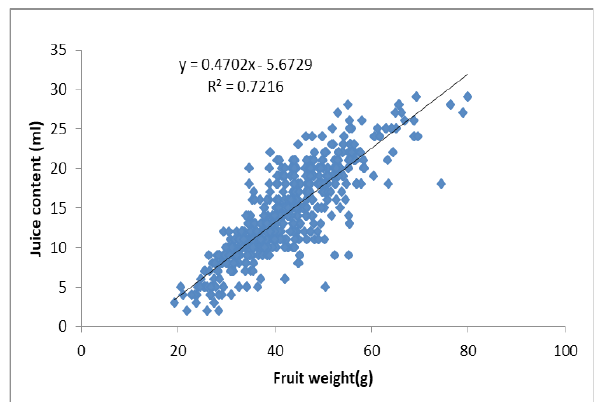
Figure 9. Relationship between fruit weight and juice con-